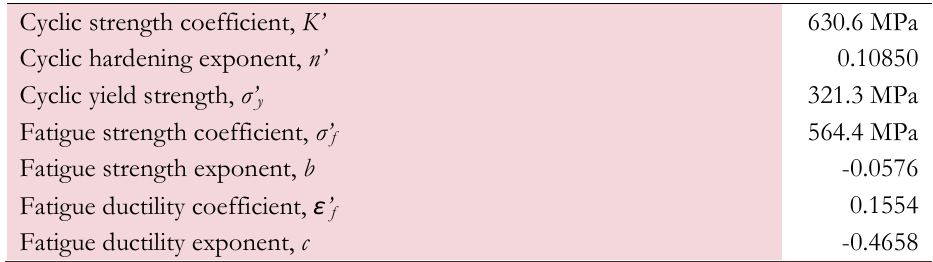
Table 2: Monotonic properties of St52-3N steel.